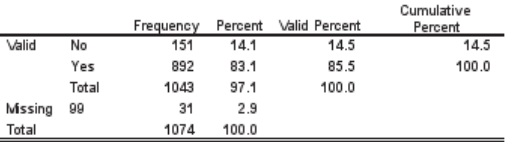
<Table 12> Should K-Pop Artists Communicate with Their Fans in a Language Fans Understand, Fan Engagement Rate Would Be